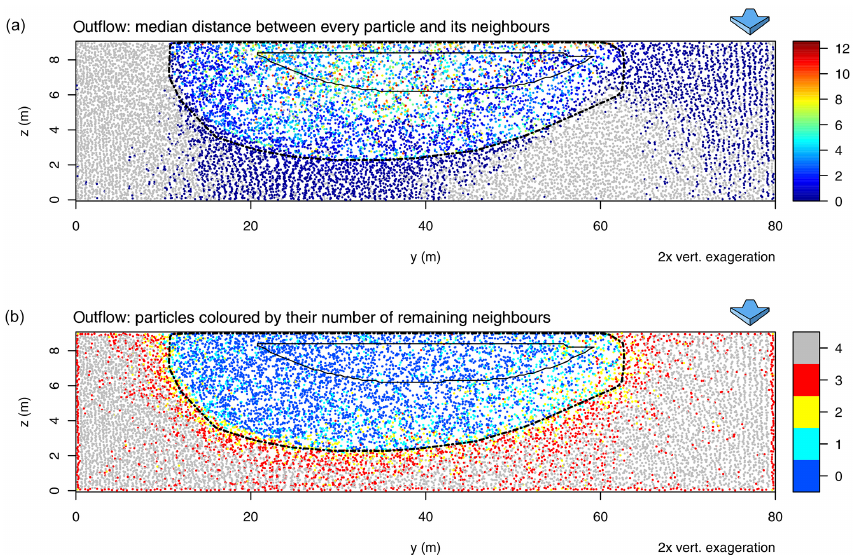
Figure 10. Particles on the model outflow face. (a) Median distance between each particle and its eight inflow-face neighbours computed on the outflow face. (b) For each particle on the outflow face, number of remaining neighbours from their four inflow-face neighbours. The black line represents the shape of the trough fills projected on the outflow face and the dashed line represents convex hull of the particles on the outflow face that flowed through the trough fills. The blue arrow indicates the main flow direction.